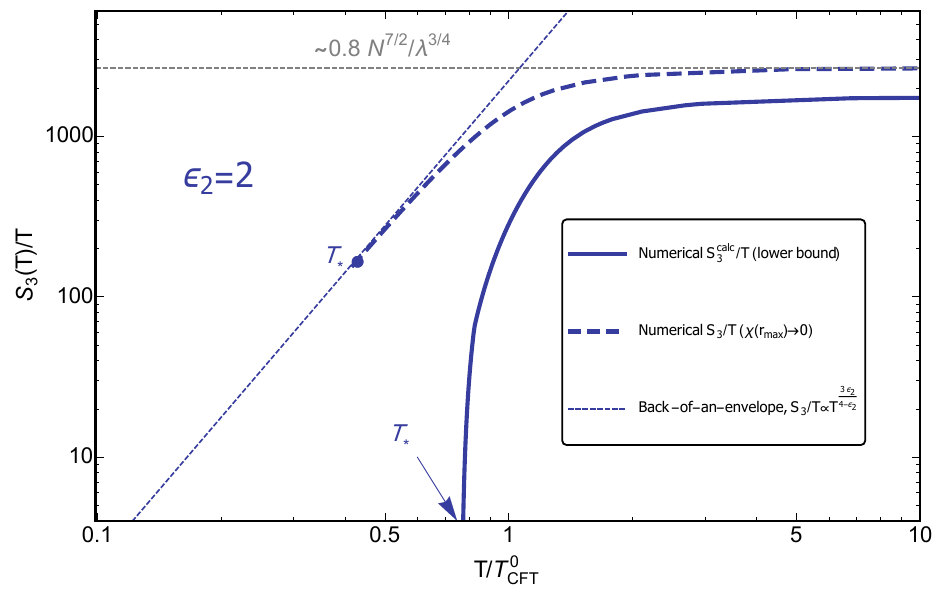
Figure 4 . Estimates of the thermal tunneling bounce action, S 3 ( T ) /T , as a function of the tem- perature T , in units of the CFT temperature today, T 0 . We compare three different estimates CFT discussed in section 4.2 and appendix C. The solid line shows our numerical evaluation of the cal- culable part of the S 3 ( T ) /T bounce action. Since we discard the non-calculable contribution, this should be understood as a lower bound on the total action. The corresponding temperature T ∗ , indicated by the arrow, should be viewed as a rough upper bound. As discussed in the text, this value of T ∗ agrees with our back-of-the-envelope estimate, eq. (4.11). The dashed line is another numerical calculation, obtained by integrating the bounce action all the way to χ = 0 , using the potential of eq. (3.3). The corresponding T ∗ is shown next to that line. We expect the physical T ∗ to lie around the above two values. The thin dashed line shows the behavior of the rates using our back-of-the-envelope analytical understanding (See eq. (4.12)). These results show that at around T ∗ the bounce action rapidly falls (and correspondingly the decay rate skyrockets) as expected. For this plot we fixed (cid:15) 2 = 2 , λ = 1 / 30 and N = 5 . Furthermore, we choose χ ∗ to be such